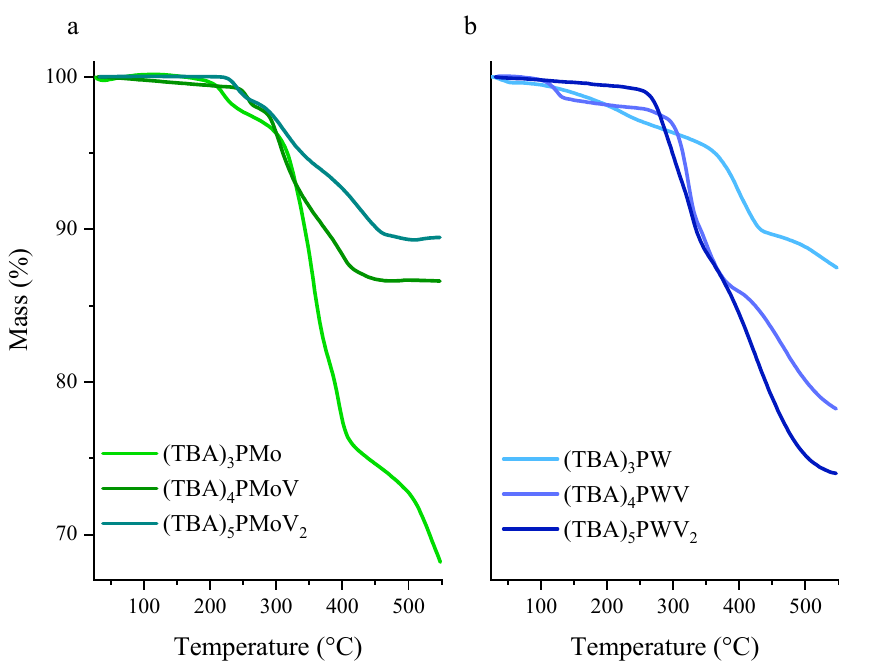
Figure A1. TGA diagrams of pure and V-substituted Mo ( a ) and W ( b ) Keggin-type polyoxometalates.